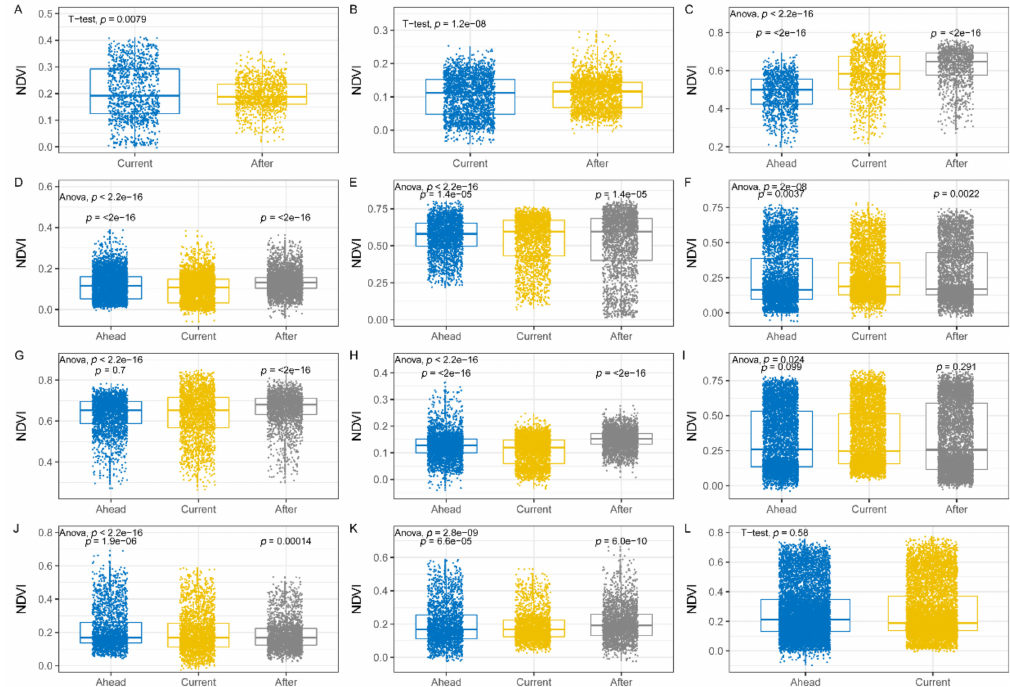
Figure 5. ANOVA analysis of month-fold NDVI response to water allocations: ( A – L ) represents stages 1–12,